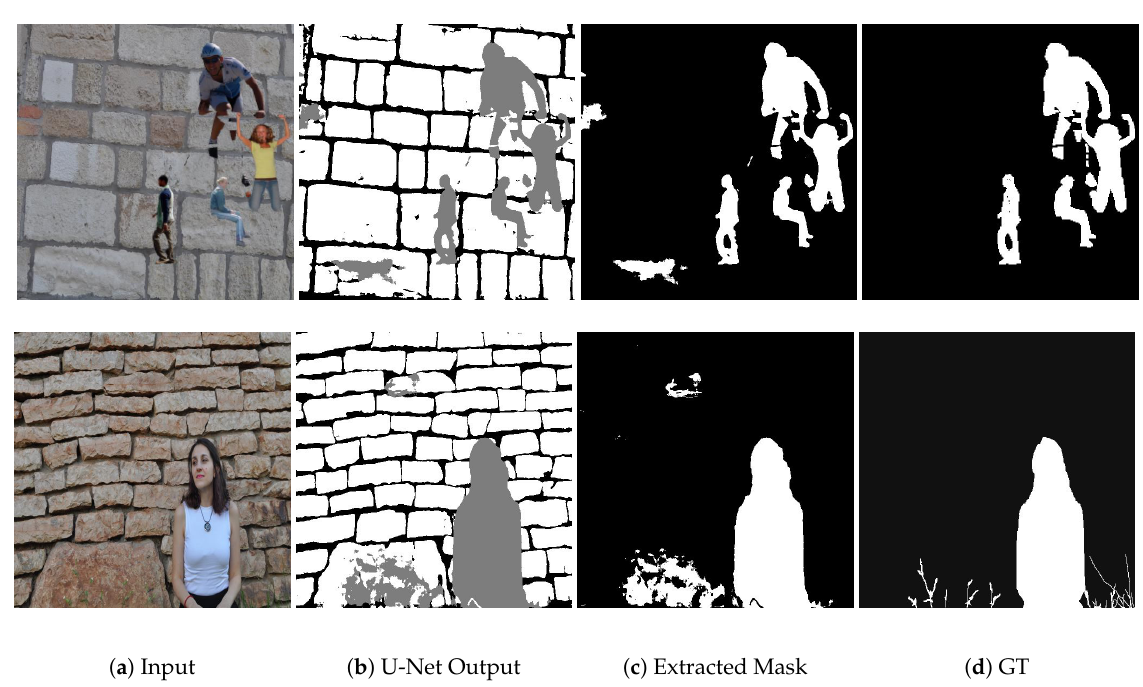
Figure 7. Pre-processing Stage results: ( a ) Input: wall image occluded by irregular objects (first row: synthetic occluding objects, second row: real occluding objects), ( b ) U-Net output with brick, mortar and occluded classes ( c ) automatically estimated occlusion masks, ( d ) Ground Truth